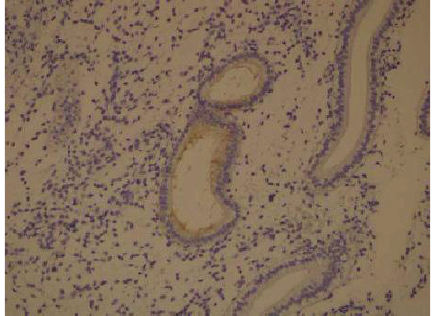
Figure 1: Immunohistochemical staining of glycodelin positive control in chorion villous tissue ( × 20).